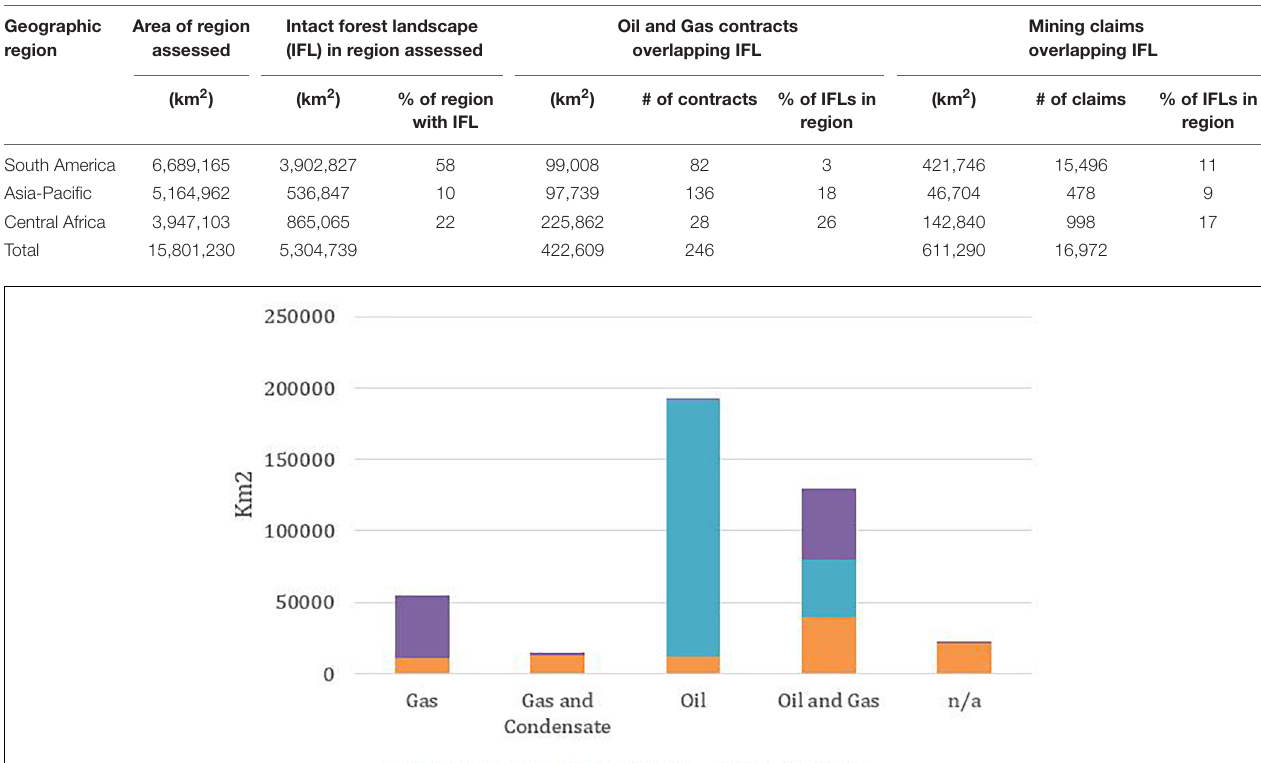
TABLE 1 | A summary of the extent and both Oil and Gas contracts and Mining claims overlapping with IFLs for each region and overall. Geographic region